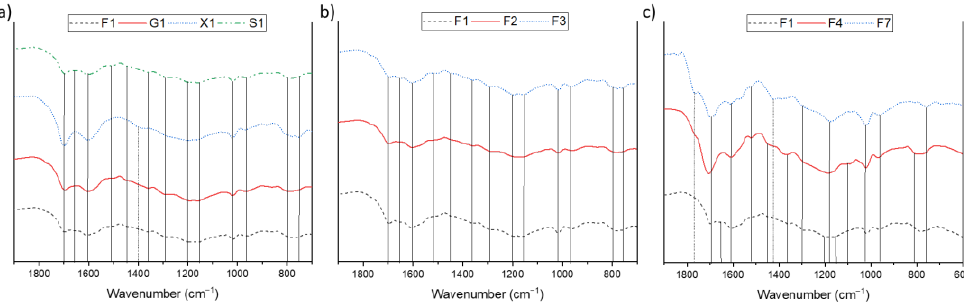
Figure 5. IR-spectra of different humins; ( a ) humins of different sugars catalyzed by sulfuric acid in neat water ( b ) fructose humins using different acids in water ( c ) fructose humins catalyzed with sulfuric acid in various solvents.